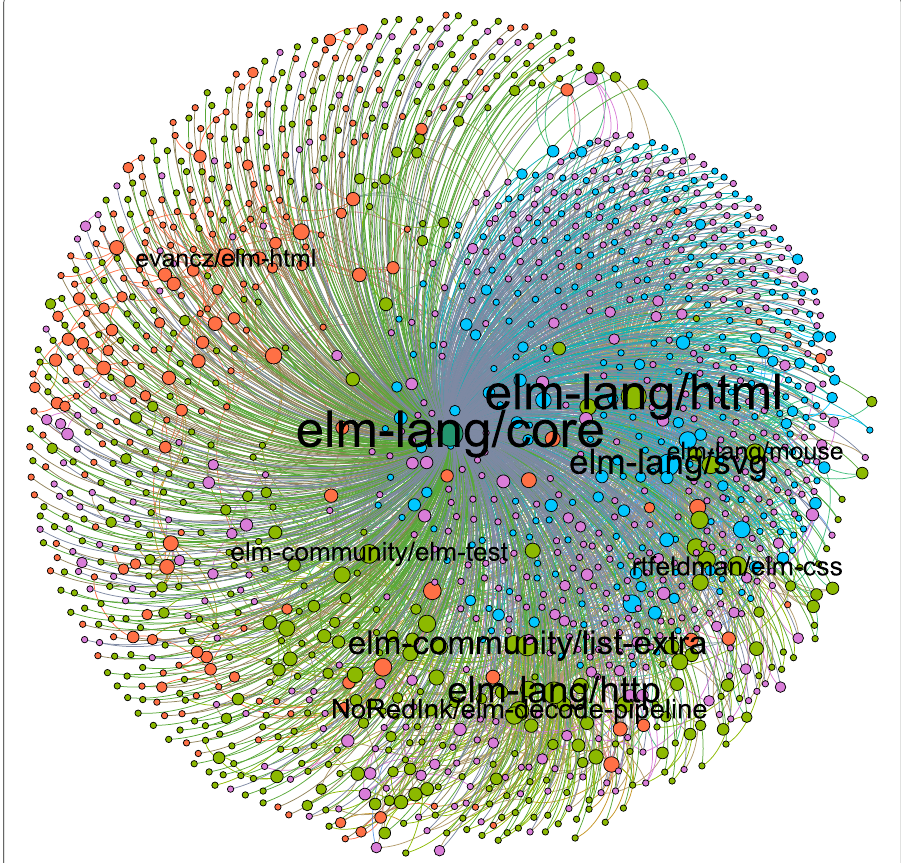
Fig. 1 Elm network. Elm network visualised using Gephi . Node and label size corresponds to out-degree. Each node i is coloured according to the strongest strength of community membership given by κ i as described in the Methods section. Legend: light-green corresponds to the community we labelled as elm-lang/core , purple to elm-lang/http , blue to elm-lang/html , and orange to evancz/elm-html , dark-green to unassigned nodes, i.e. those without any